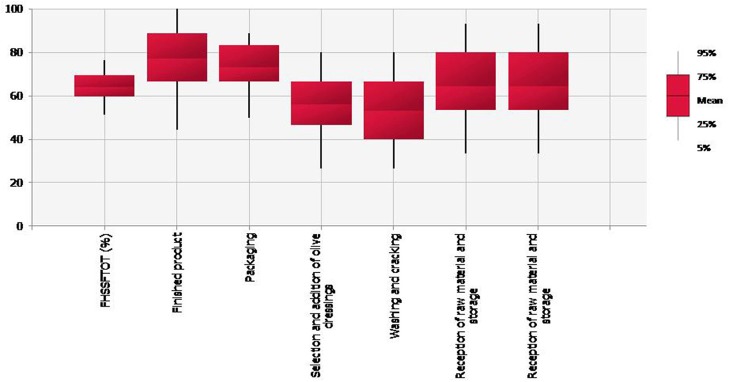
Boxplot representing the mean, 5, 25, 75, and 95th values of the Performance Hygiene and Safety Score at the different processing steps (PHSSFi) together with the global PHSSFTOT (%).